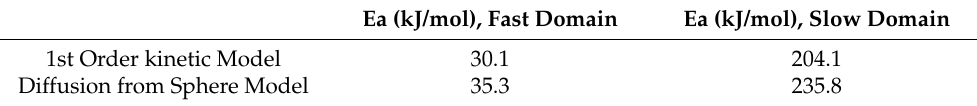
Table 7. Estimated activation energies for a first-order and a diffusion-based model.